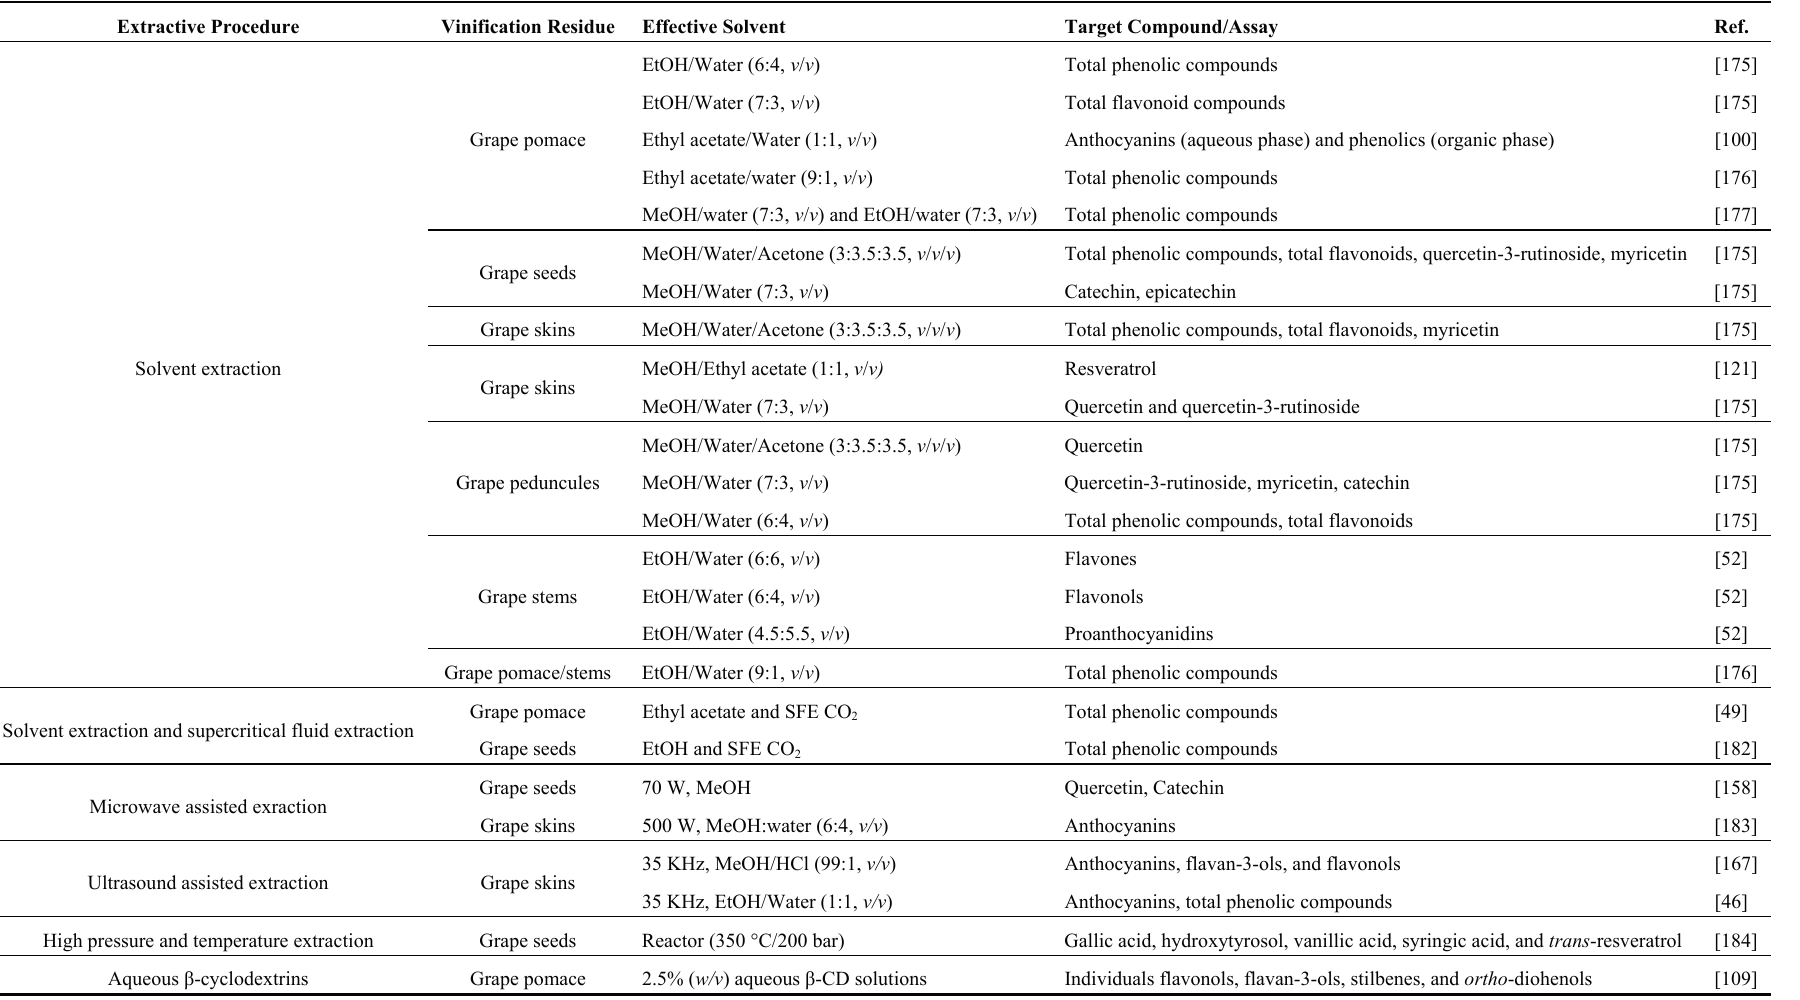
Table 8. Polyphenol extraction techniques and solvents for industrial application of wine-industry